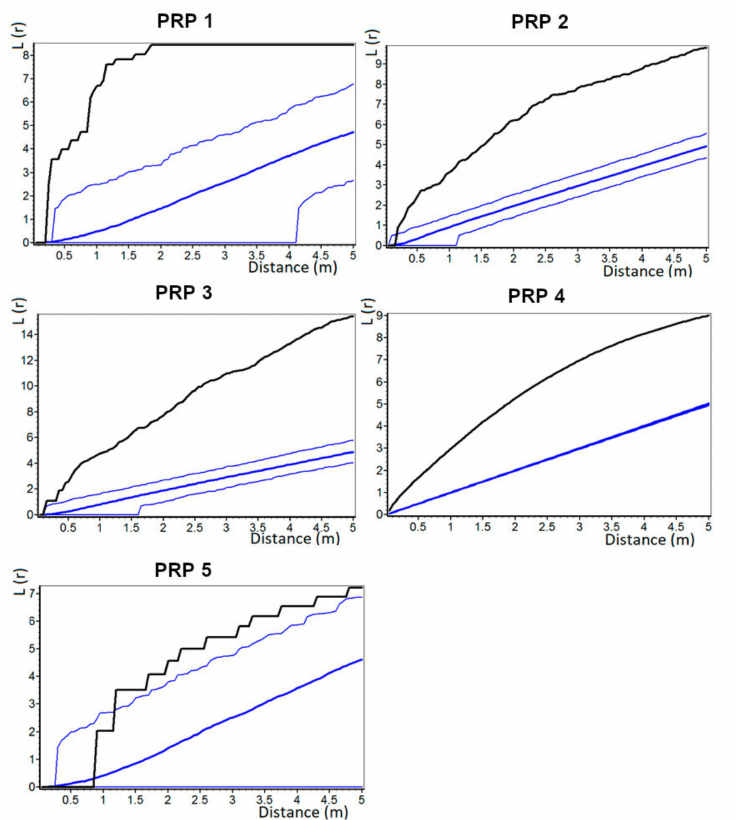
Figure 6. Horizontal structure of the natural regeneration of beech stands on permanent research plots (PRP) 1–5 expressed by L -function; black line represents the L -function for real distances of trees on plots, thick blue line shows the mean course for random spatial pattern of trees, and two thinner central curves represent a 95% confidence interval; when the black line of tree distribution on plot is below this interval, it indicates a tendency of individuals towards the regular pattern, and if it is above this interval, it suggests a tendency to aggregation.